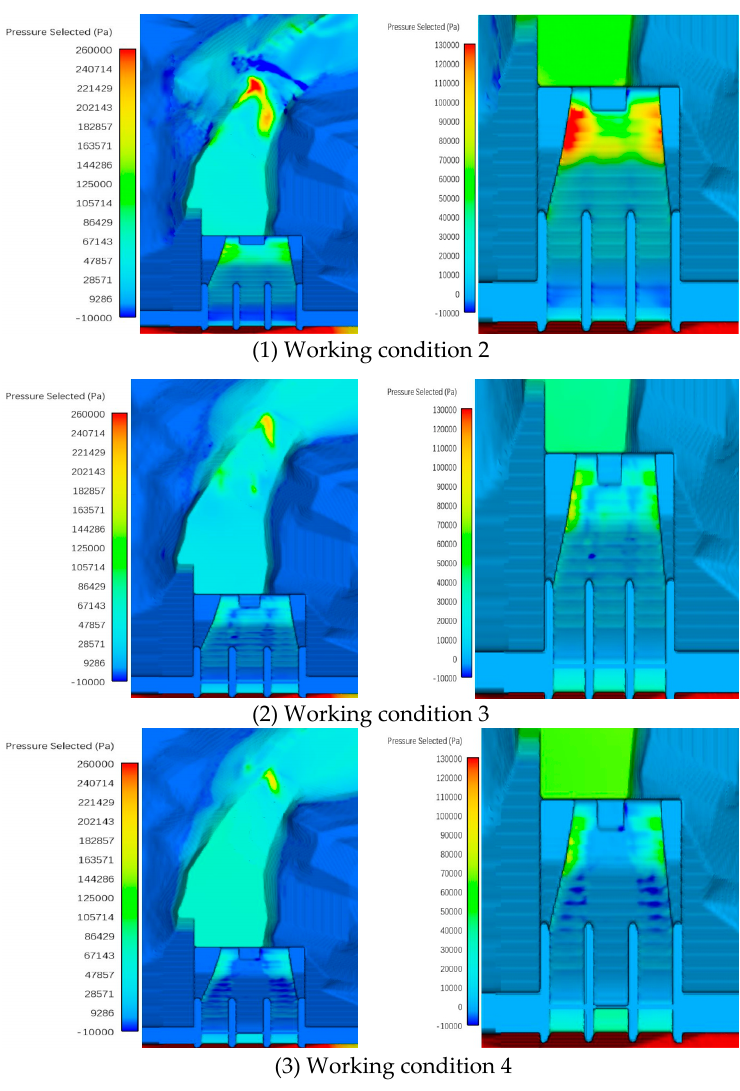
Figure 14. Wall surface pressure distribution on the discharge structures.